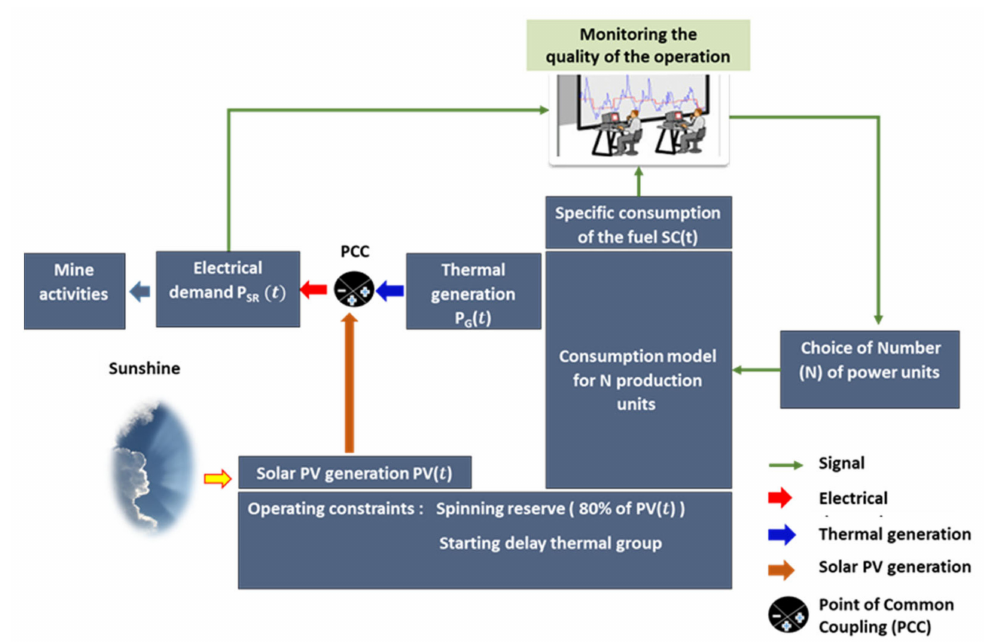
Figure 13. Functional diagram of the operation of the Essakane Hybrid Power